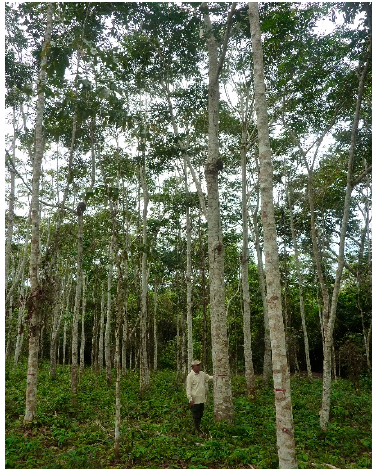
Figure 17. Dipteryx ferrea and Simarouba amara in one of the management units planted in 2008/2009.